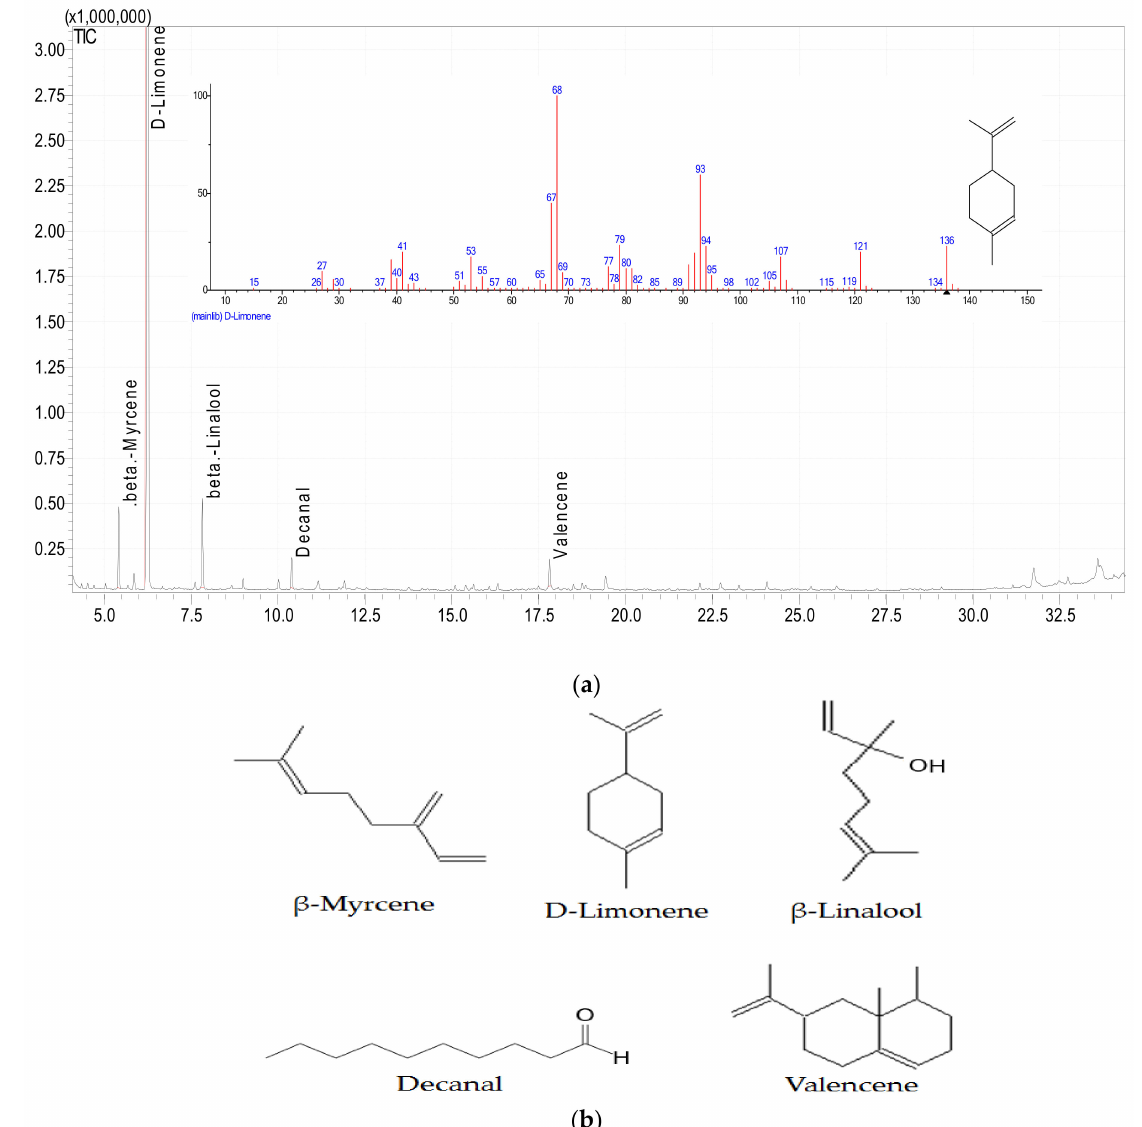
Figure 4. ( a ). Essential oil compounds of orange peel powders by GC-MS. ( b ). Chemical structure of the different compounds in the C. sinensis peel essential